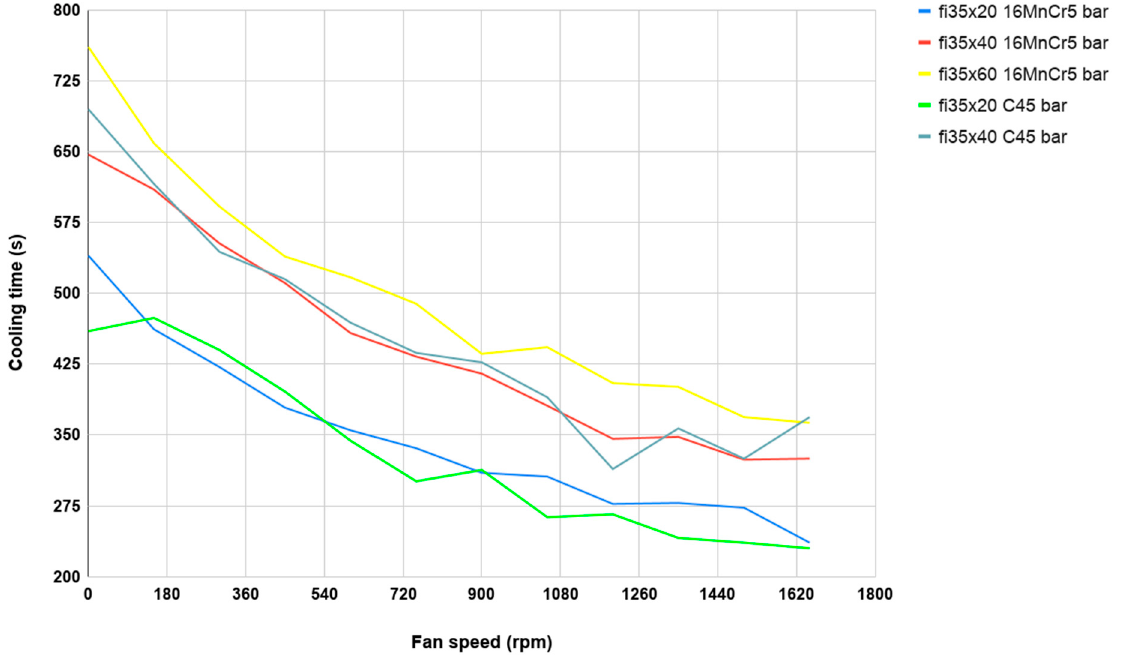
Figure 13. The cooling curves of 16MnCr5 and C45 samples with the dimensions ∅ 35 × 20 mm, ∅ 35 × 40 mm and ∅ 35 × 60 mm, from forging temperature 1100 ◦ C to 400 ◦ C, in the function of the speed of